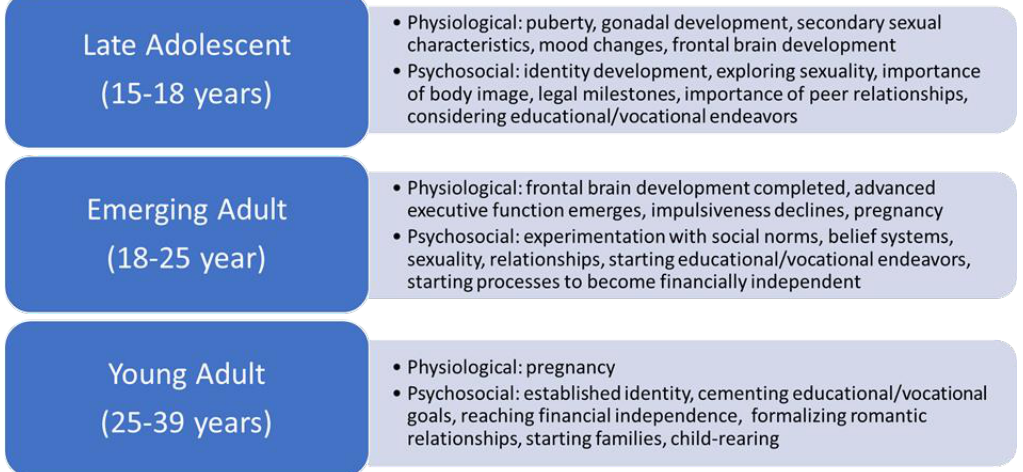
Figure 1. Physiologic and psychosocial aspects of normal developmental stages in AYAs.